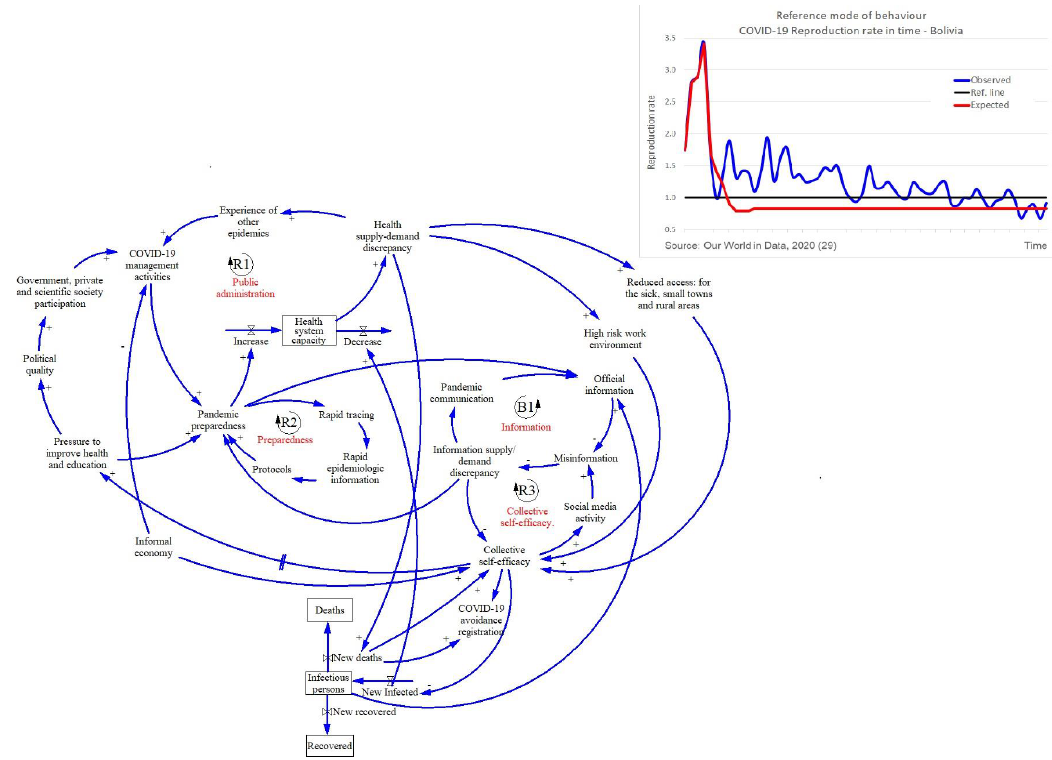
Figure 1. Reference mode and GMB Bolivia. Solid lines indicate positive relationships while a dotted lines indicate negative relationships. Reinforcing feedback loops are represented by an R, and balancing feedback loops are represented by a B.